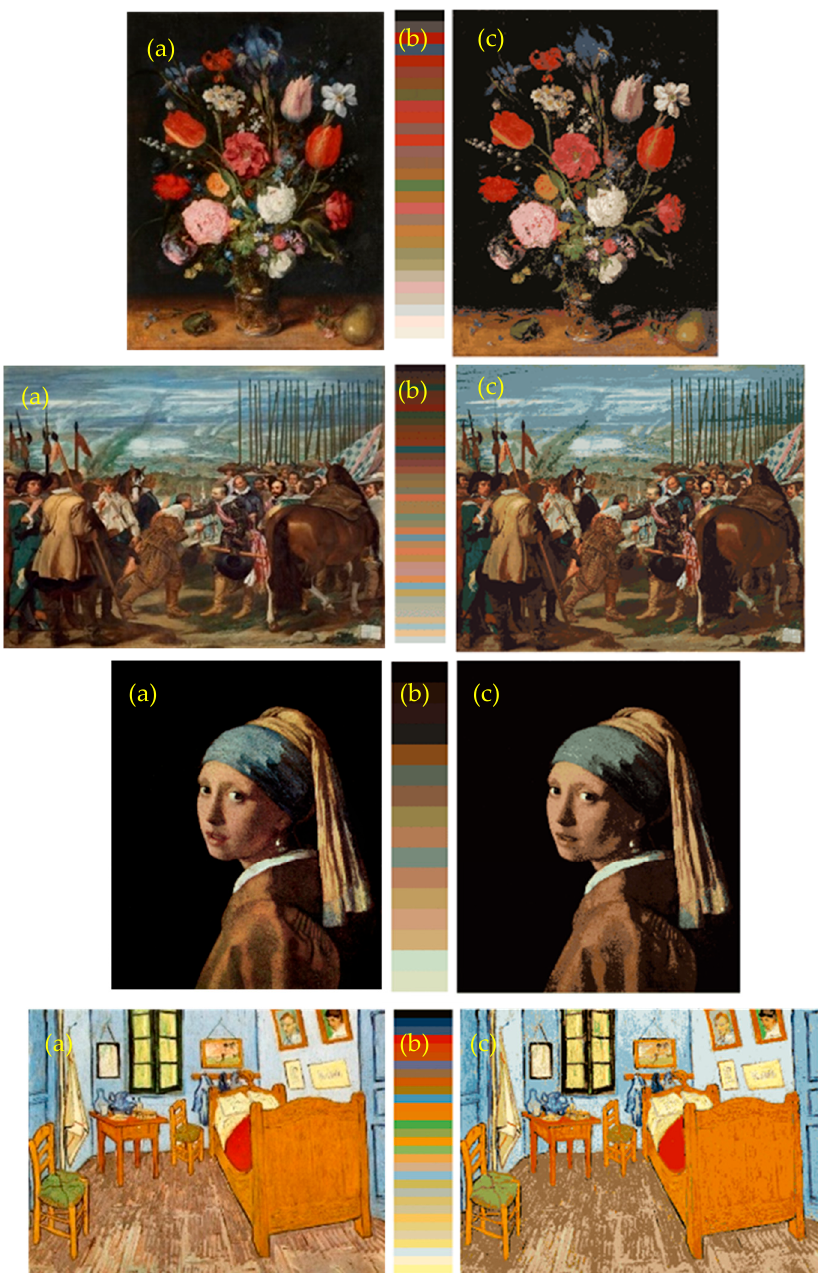
Figure 7. ( a ) Original painting and ( c ) its corresponding segmented counterpart based on the subjective relevant colours describing the colour palette of the painting ( b ). The numbers of relevant colours in each palette were 29, 41, 16, and 32, respectively, from the top to bottom images. The correlation coefficients between each original image and each segmented image were 0.9554, 0.9718, 0.9148, and 0.9249,